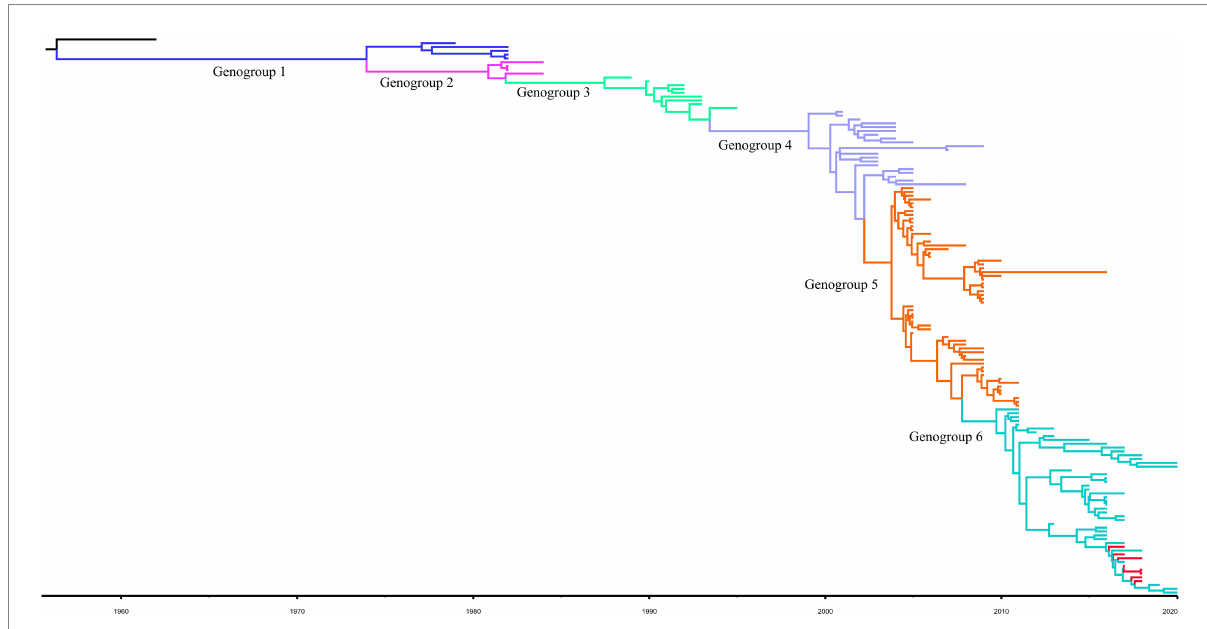
FIGURE 2 Bayesian MCC tree for the complete S gene of HCoV-229E. Genotype classification is color-coded and sequences obtained in this study are colored red. BEAST v.1.10.4 was used to estimate the most recent common ancestor (tMRCA). A nucleotide substitution model GTR + I + G and a strict clock were used for evolution